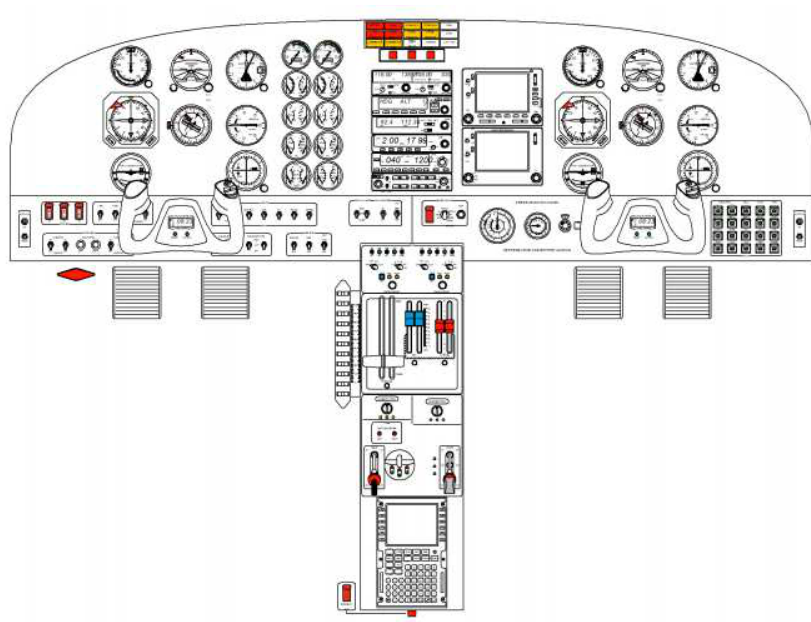
Figure 1. FNTP II MCC simulator: twin engine piston aircraft with folding landing gear